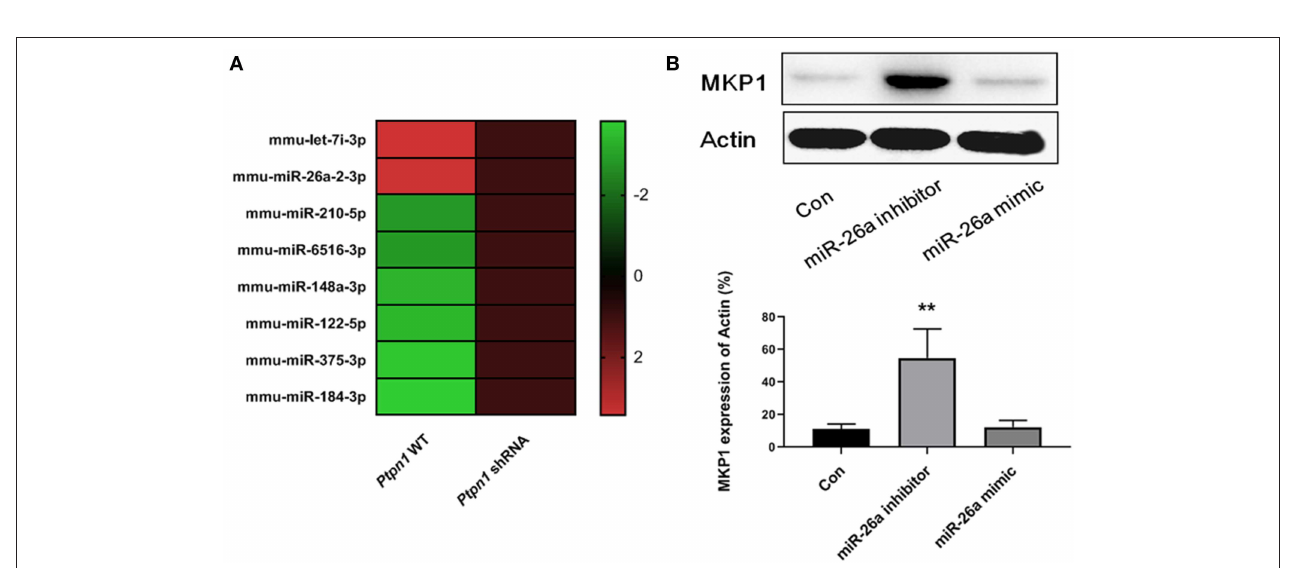
FIGURE 5 | Inhibition of PTP1B promotes MKP1 via decreasing miR-26a production. (A) miRNAs expression profiles analysis. Ptpn1 WT cells and knockdown cells were incubated for 24h and then harvested for deep-sequencing analysis. Three independent experiments were performed and fold changes (in log2 value) of control group are listed in heatmap. (B) The expression of MKP1 is regulated by miR-26a. Cells were treated by miR-26a mimic or miR-26a inhibitor for 24h respectively, and harvested for Western blot detection. Data are expressed as mean ± SD of three independent experiments. ** p < 0.01 indicates statistically significant differences as compared with the control